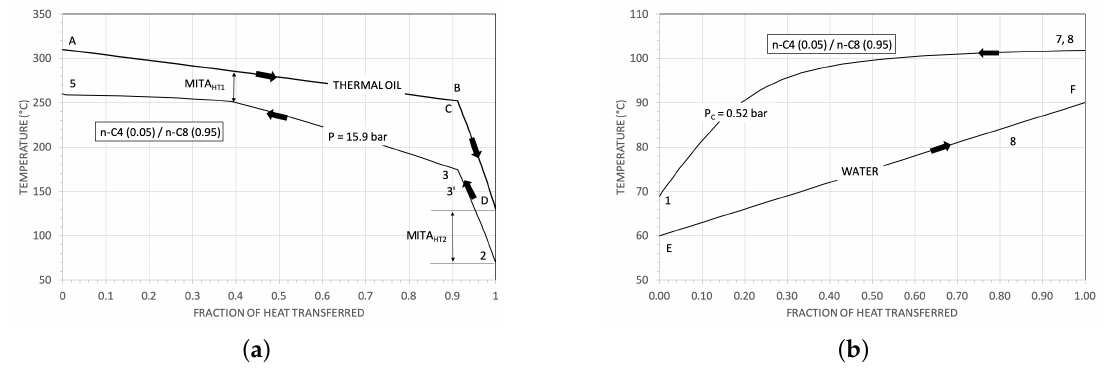
Figure 10. Temperature-Thermal Power Exchanged for the cycle operating with the mixture n-C4 (0.05)/n-C8 (0.95) in the ( a ) High Temperature heat exchangers. ( b ) Condenser. The mixture n-C6/n-C8 has a critical temperature greater than T max only for a molar fraction of n-C6 lower than 0.5 and the equi-molar mixture ( T cr = 272 ◦ C) gives a thermodynamic cycle efficiency of 0.18 at P E , dew = 23 bar and at P C , dew = 0.775